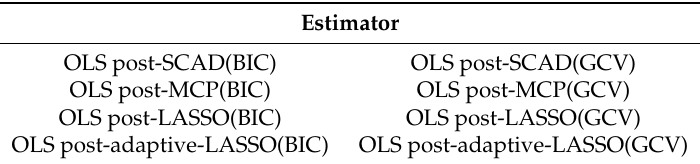
Table 1. Penalized least squares estimators. SCAD, smoothly clipped absolute deviation; MCP, minimax concave